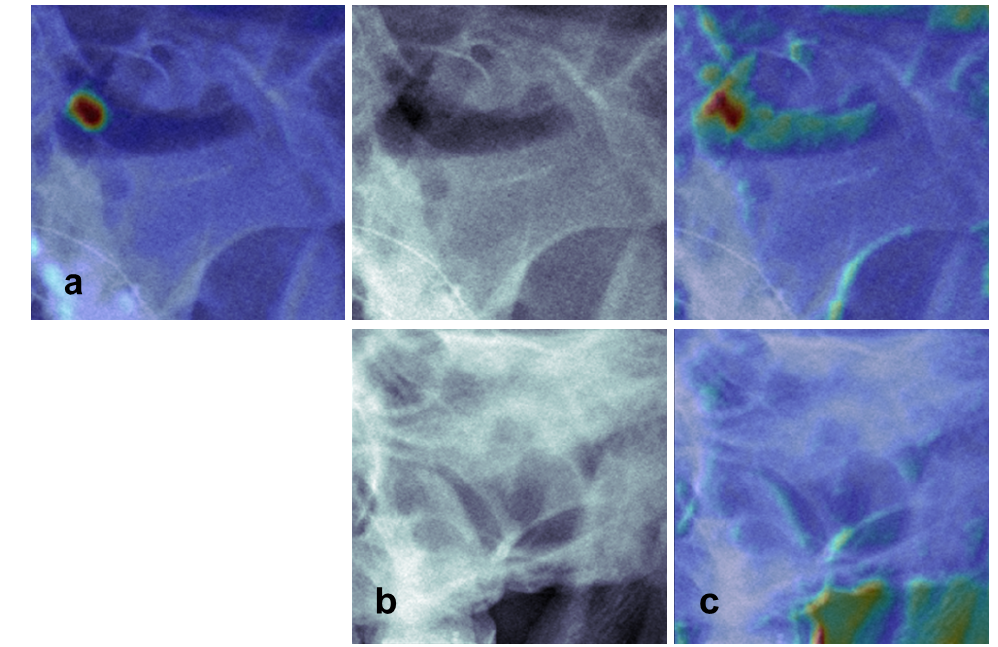
Figure 5. Comparison of the class activation maps (CAMs) of the single primary view and multi-view model. ( a ) CAM of the single primary view model (Waters’ view). ( b ) Original radiographs showing maxillary sinusitis with air-fluid level (upper row, Waters’ view; lower row, Caldwell view) ( c ), CAM of the multi-view model (upper row, Waters’ view; lower row, Caldwell view). Single primary view model ( a ) misclassified as mucosal thickening because the area above the horizontal fluid line is not recognized. In the case of the multi-view model ( c ), the prediction is correct as the activated area is more expanded on Waters’ view (upper row), while no clear activation is found in the sinus area on the secondary view (lower row).